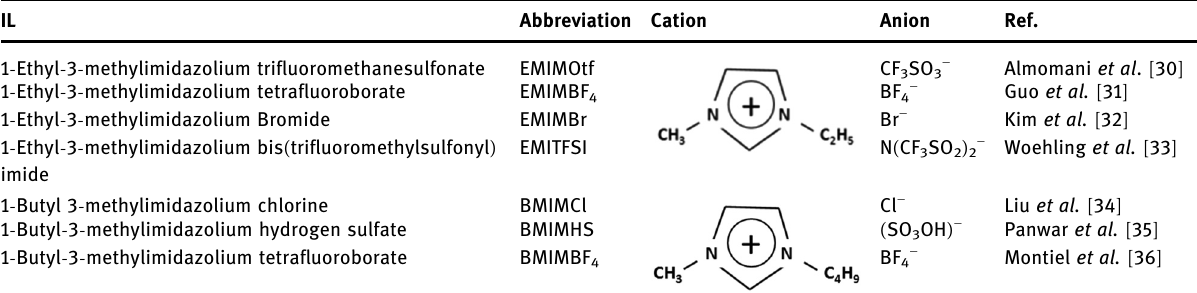
Table 1: Commonly used ILs for iEAP IL